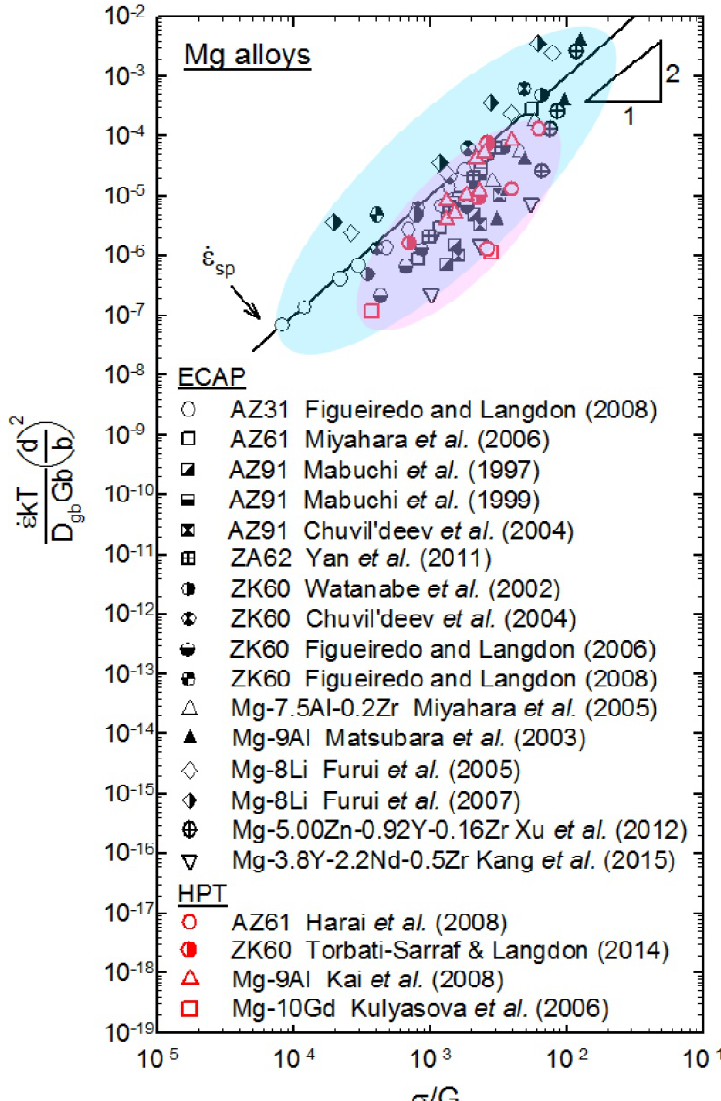
Fig. 6. A compilation of data for a series of Mg alloys [29] after ECAP [48-63] and HPT